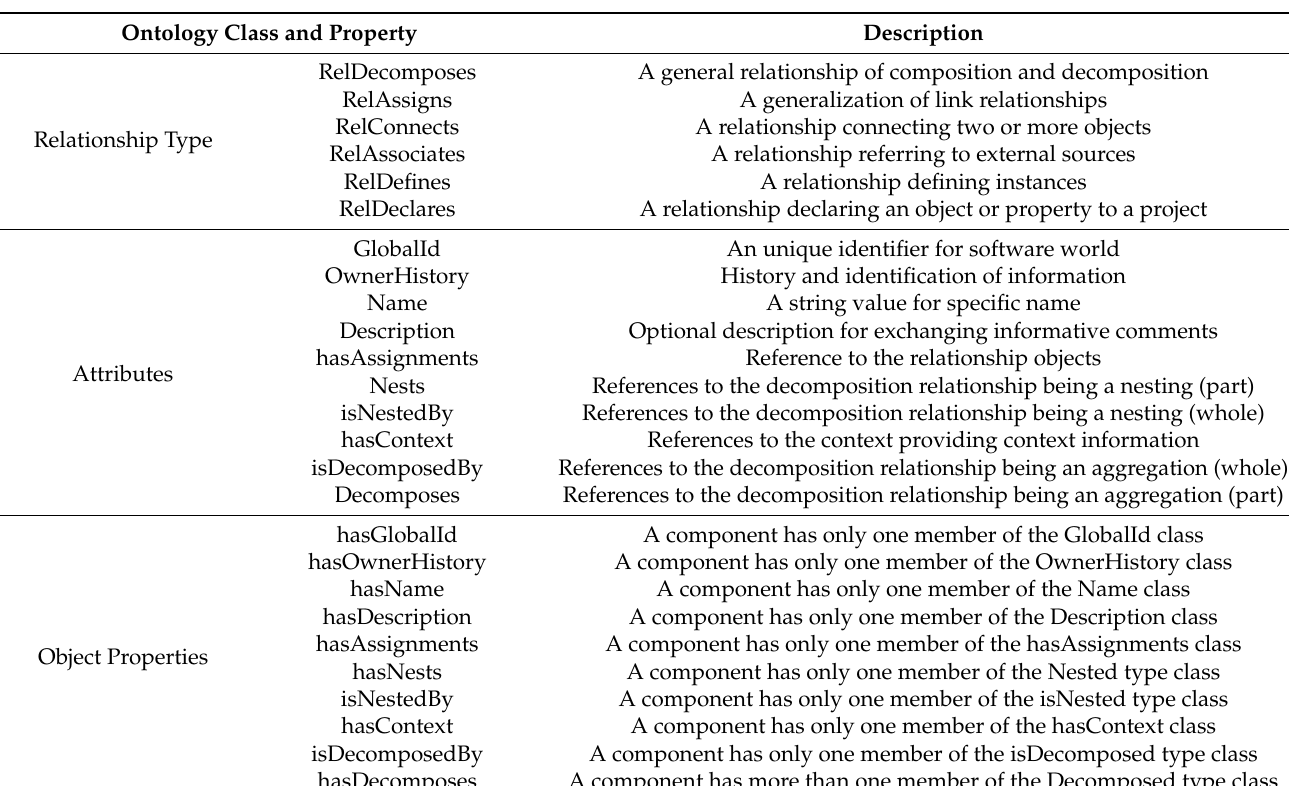
Table 4. Definition of delivery requirements relationship, attributes and properties based on